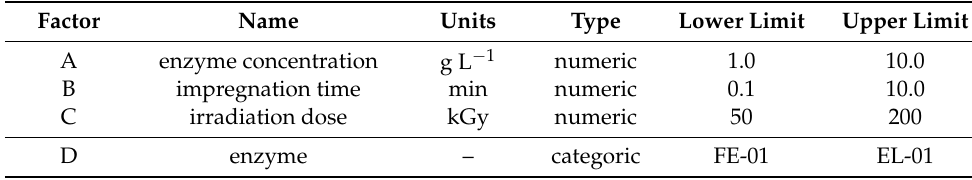
Table 1. Investigated factors of the I-optimal RSM